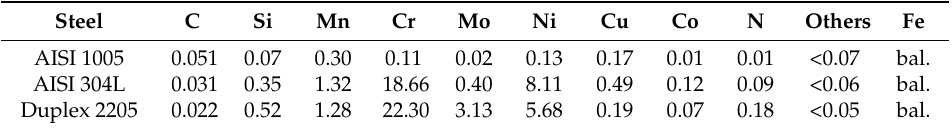
Table 1. Chemical compositions of the materials analyzed (wt.